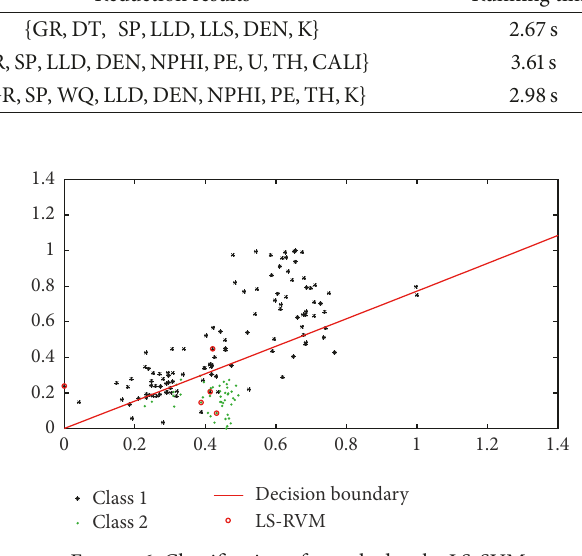
Figure 6: Classification of sample data by LS-SVM.